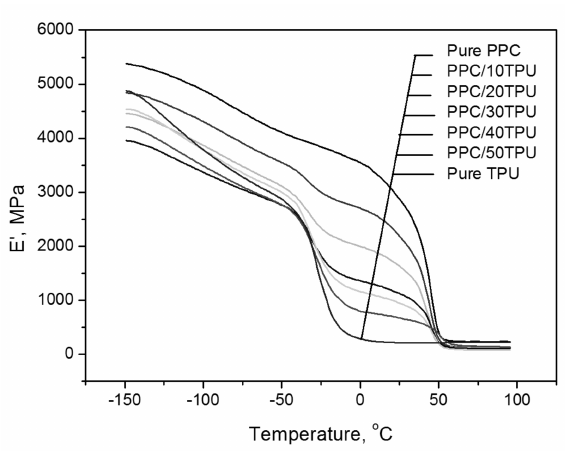
Figure 9. Storage modulus versus temperature for PPC, TPU and PPC/TPU blends.